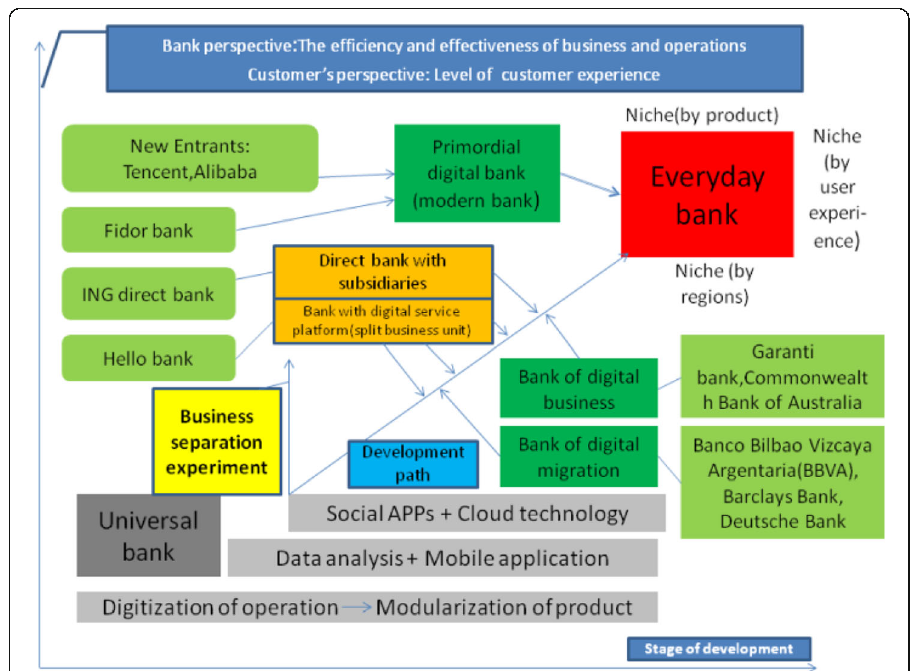
Fig. 1 Process for traditional banks to transform into Everyday